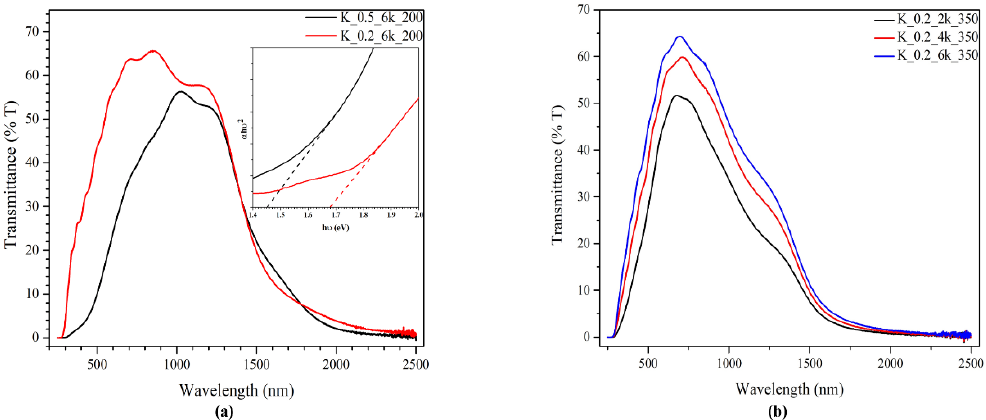
Figure 3. UV–vis spectroscopy of the CZTS thin film ( a ) prepared by ink having concentrations of 0.5 g/mL (red line) and 0.2 g/mL (black line), the insert is Tauc’s plot of corresponding CZTS thin film, and ( b ) at different spin rates: black line, 2000 rpm; red line, 4000 rpm; and blue line, 6000 rpm.